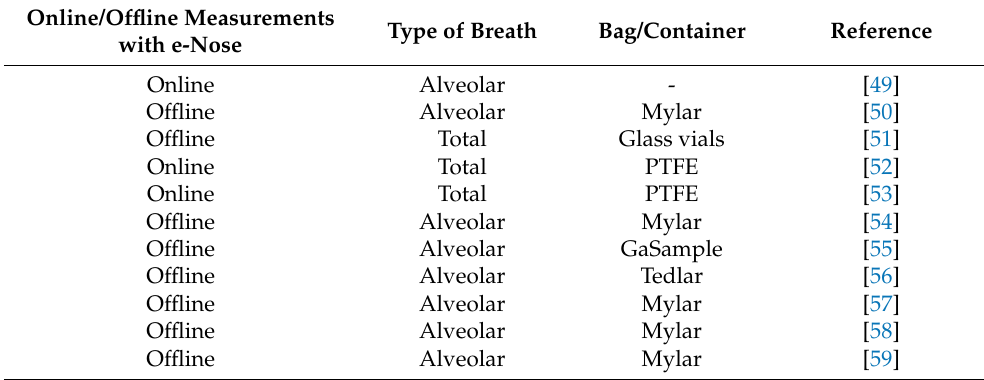
Table 1. Method, type of breath, and breath container for the analysis with CNTs-based e-nose. Online/Offline Measurements with